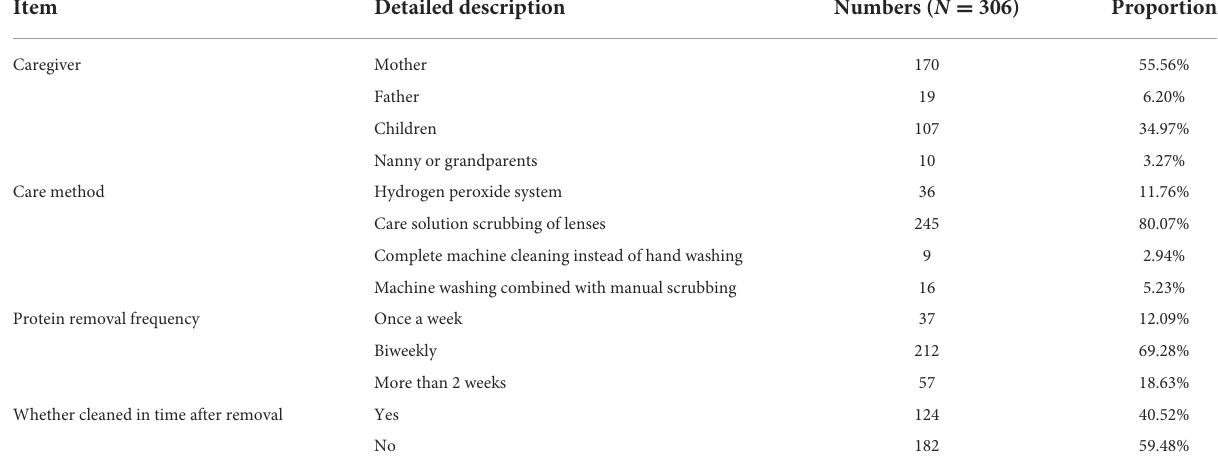
TABLE 3 The current status of daily care of OK